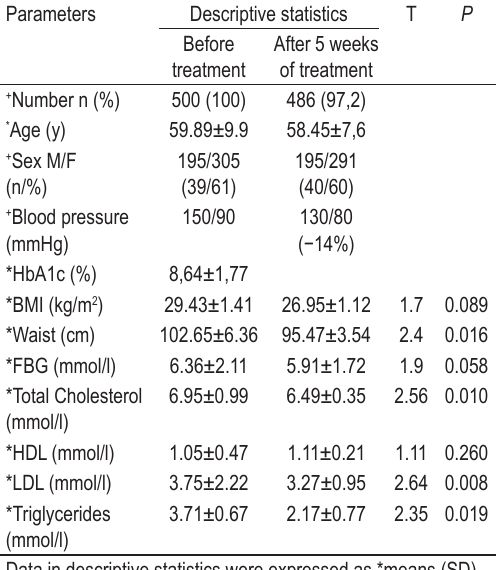
TABLE 1. Clinical and laboratory characteristics of the study